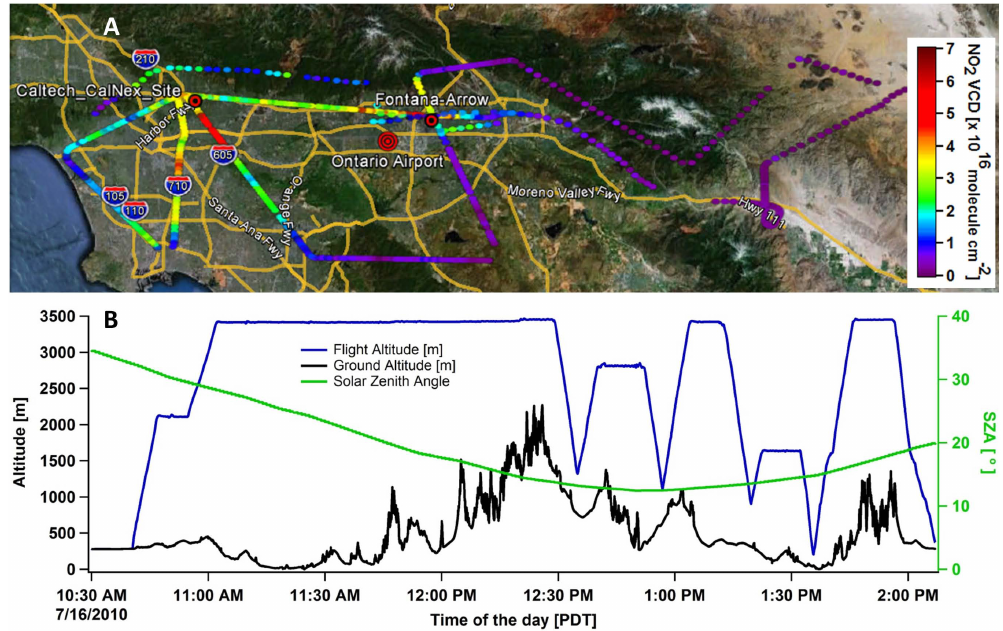
Fig. 7. (A) Map showing horizontal distribution of NO 2 VCDs below the aircraft derived from nadir measurements from RF#46 on 16 July 2010 (10:30–14:10PDT – Pacific Daylight Time) in the SCAB. MAX-DOAS instruments deployment sites and the base airport for the Twin Otter are shown as red targets. (B) Time trace of flight altitude (blue), ground altitude (black) and SZA (green) from the same